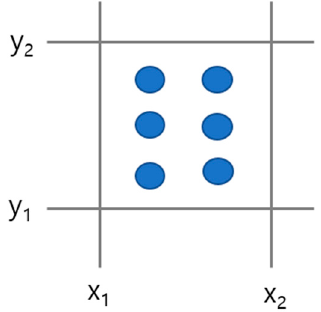
Figure 1. The continuous landslide mass in the orthogonal grid is discretized into debris-flow particles (represented as dots), which are evenly placed within the grid.